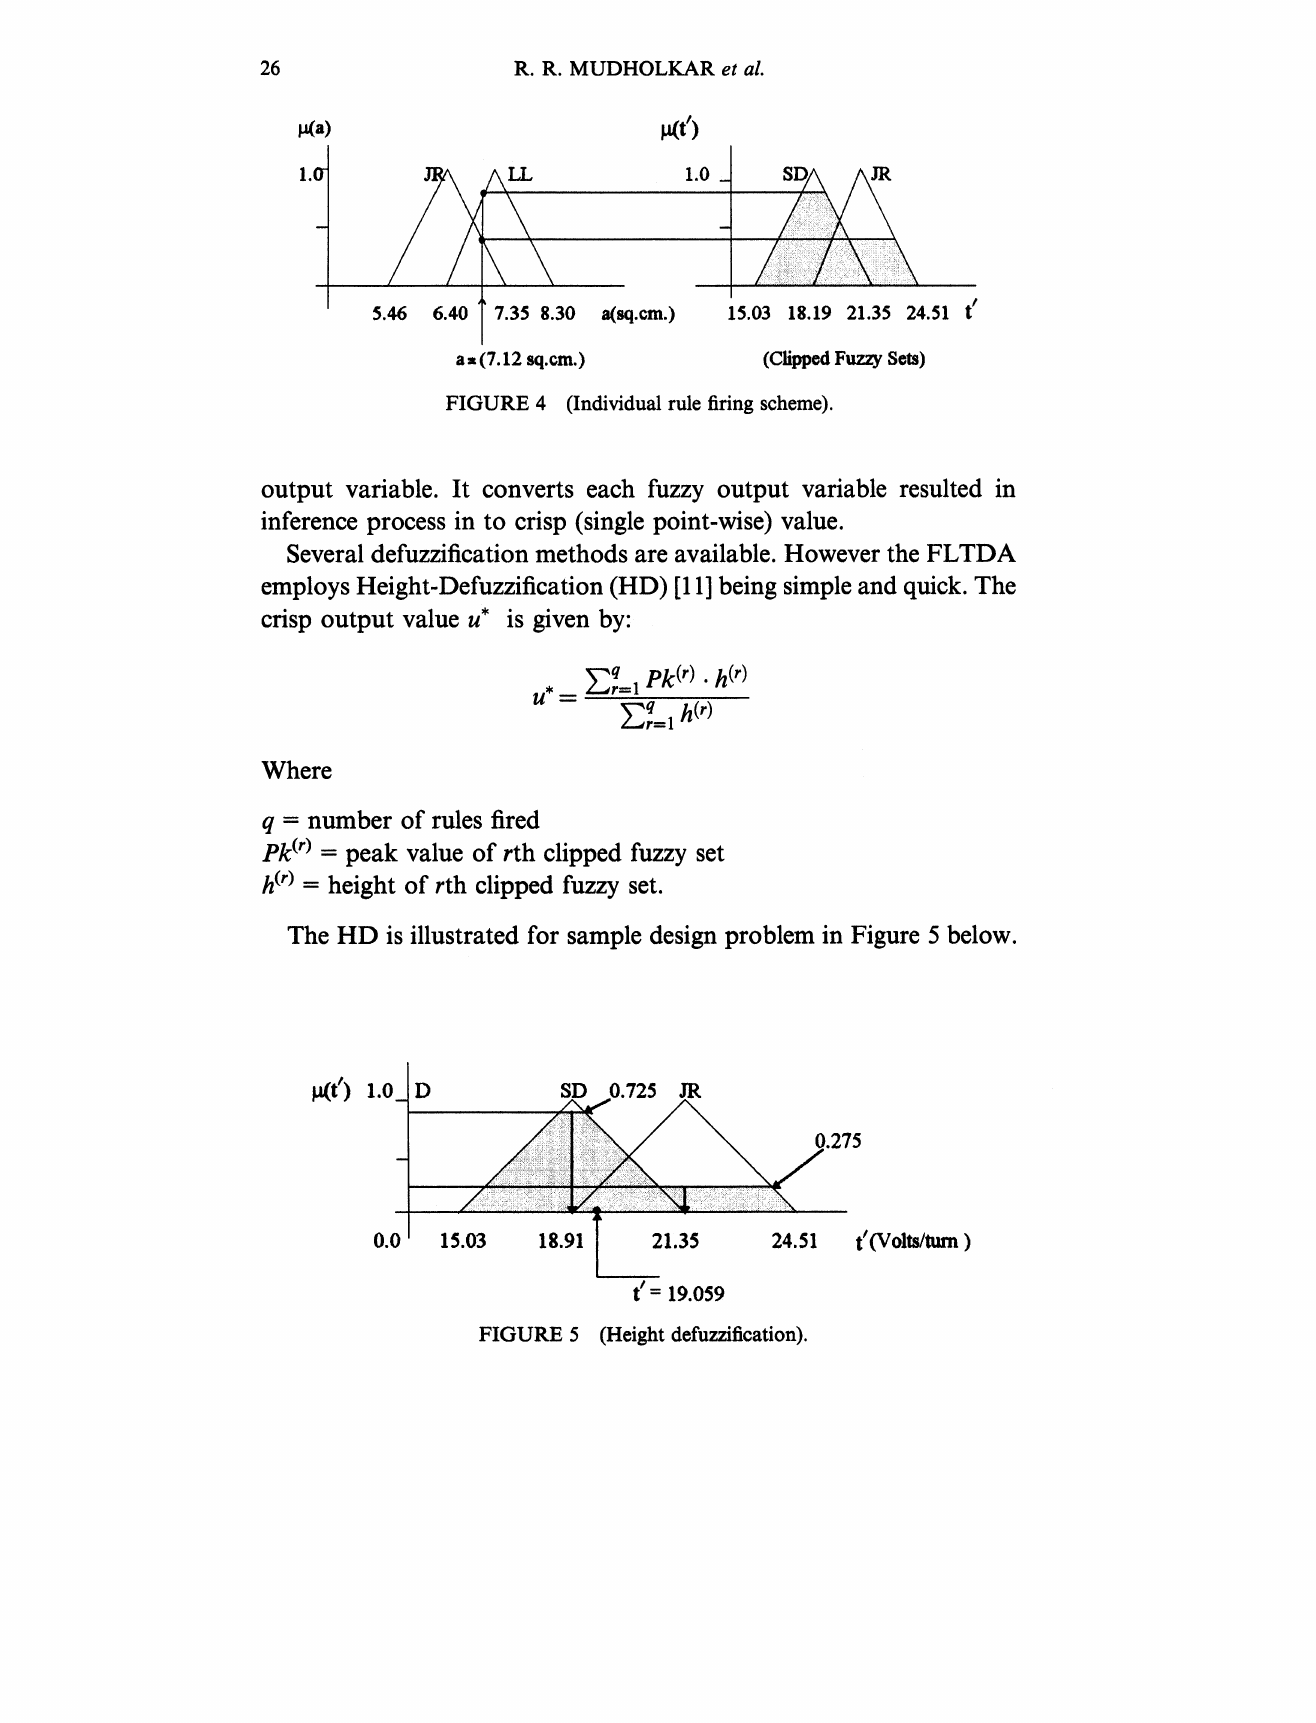
FIGURE 4 (Individual rule firing scheme).